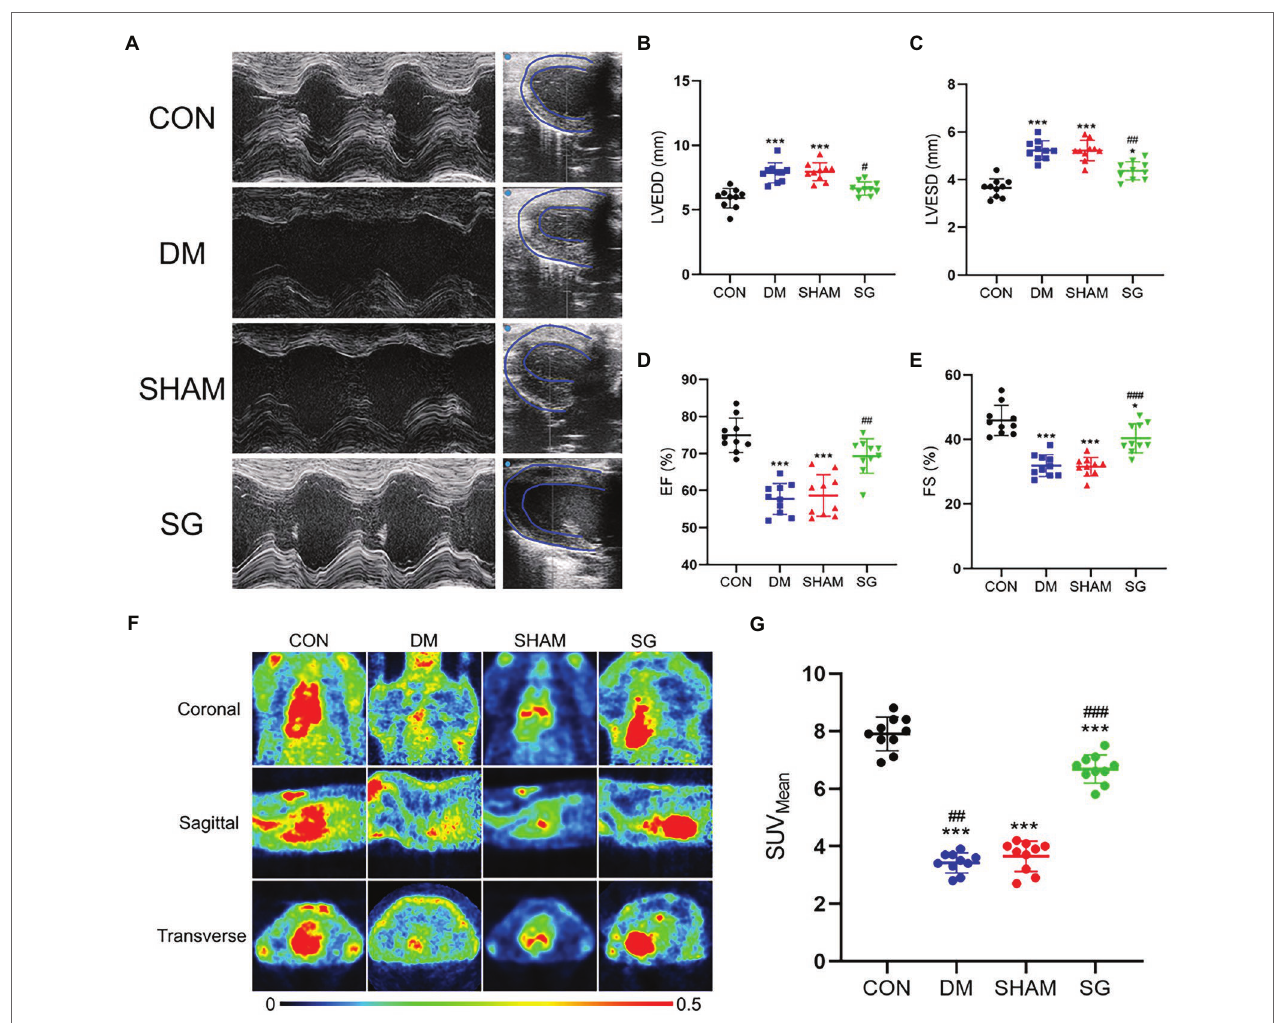
FIGURE 4 | The beneficial effect of SG on the heart function and myocardial glucose uptake. (A) The representative images of echocardiography, and the (B) LVEDD, (C) LVESD, (D) EF, (E) FS were measured and analyzed. (F) The representative heart PET images of the rats and (G) comparisons of the myocardial glucose uptake through SUV Mean . Data are expressed as means ± SEM for n = 10 per groups. * p < 0.05 vs. CON group, ** p < 0.001 vs. CON group, *** p < 0.0001 vs. CON group; # p < 0.05 vs. SHAM group, ## p < 0.001 vs. SHAM group, ### p < 0.0001 vs. SHAM group. PET, positron-emission tomography; LVEDD, left ventricular end-diastolic diameter; LVESD, left ventricular end-systolic diameter; EF, ejection fraction; FS, fractional shortening; SUV Mean , the average standard uptake value; CON, control; DM, diabetes mellitus; SHAM, sham operation; SG, sleeve